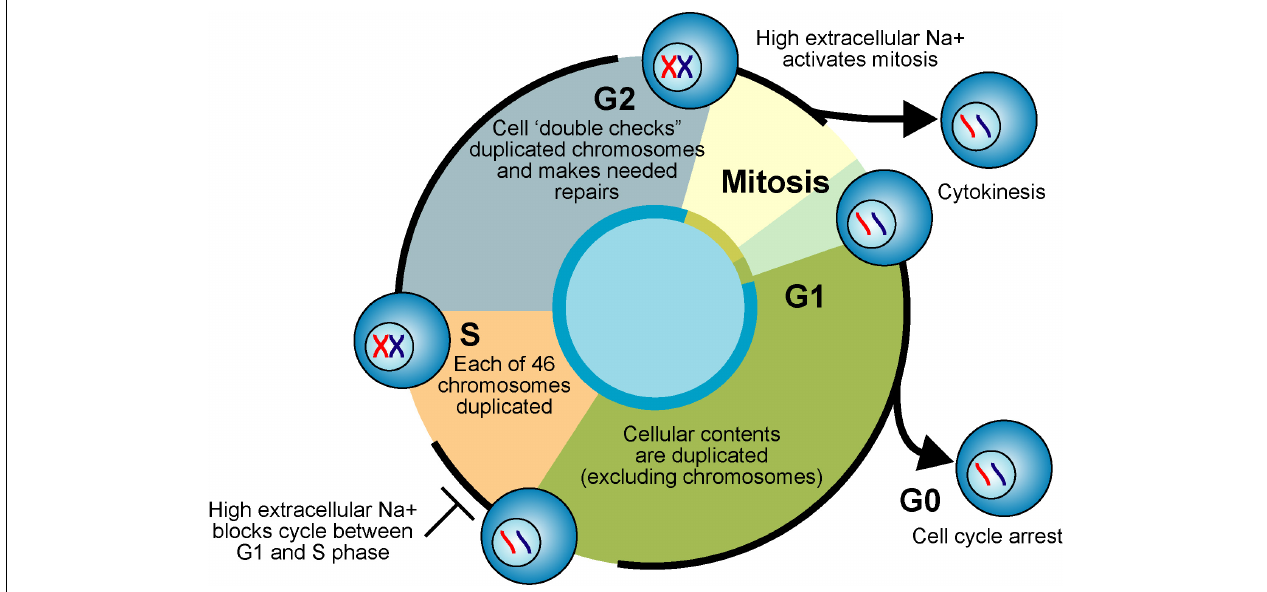
FIGURE 5 | Cell cycle and Na + . Actively proliferating eukaryote cells pass through four phases of the cell cycle. Cellular contents (excluding chromosomes) are duplicated in first gap phase (G1). Each chromosome is duplicated in synthesis phase (S). Duplicated chromosomes are “error checked” during second gap phase (G2). G1, S, and G2 are collectively called interphase. Equal division of duplicated nuclear material occurs in mitosis phase (M). Division of parent cell into two daughter cells (cytokinesis) completes the cell cycle. If nutrients are limiting or the cells are fully differentiated due to internal genetic programming, cells exit interphase and enter a “resting phase”